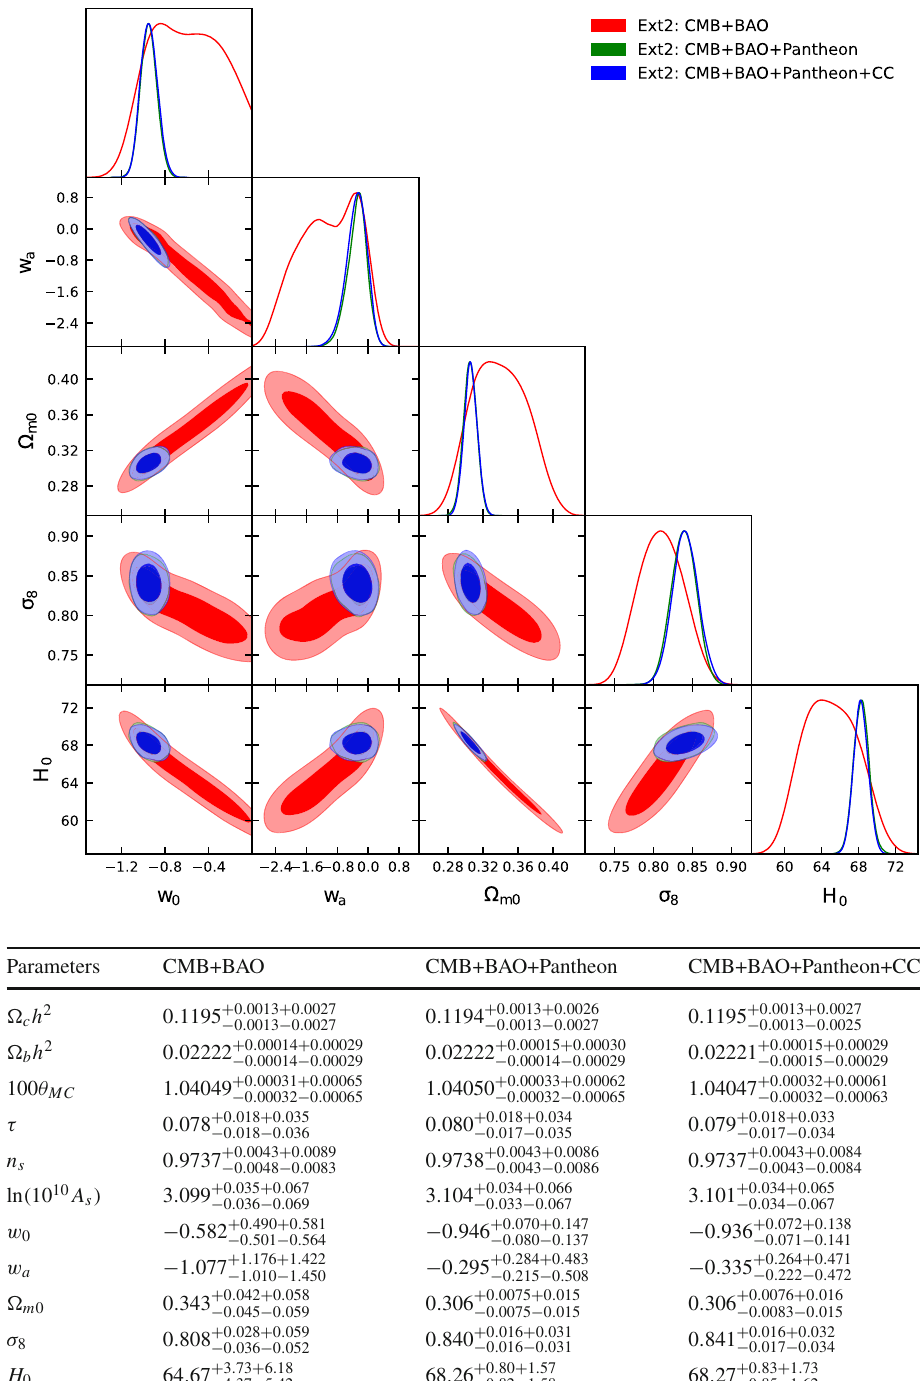
Fig. 8 68% and 95% CL contour plots for various combinations of the model parameters of the Ext2 of (8) have been shown for different observational combinations. The figure also contains the one dimensional marginalized posterior distributions for the parameters shown in the two dimensional contour plots